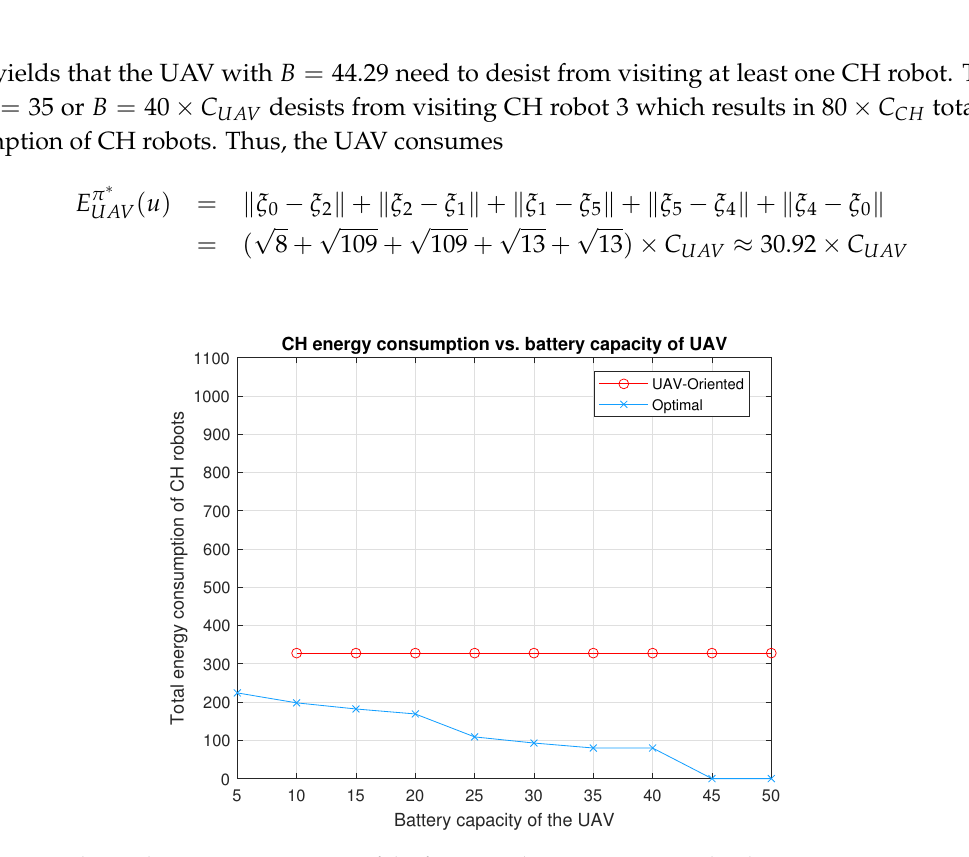
Figure 4. The total energy consumption of the five CH robots in Figure 3 under the strategies, UAV-oriented and optimal for varying battery capacities of the UAV from B = 5 × C UAV to B = 50 × C UAV